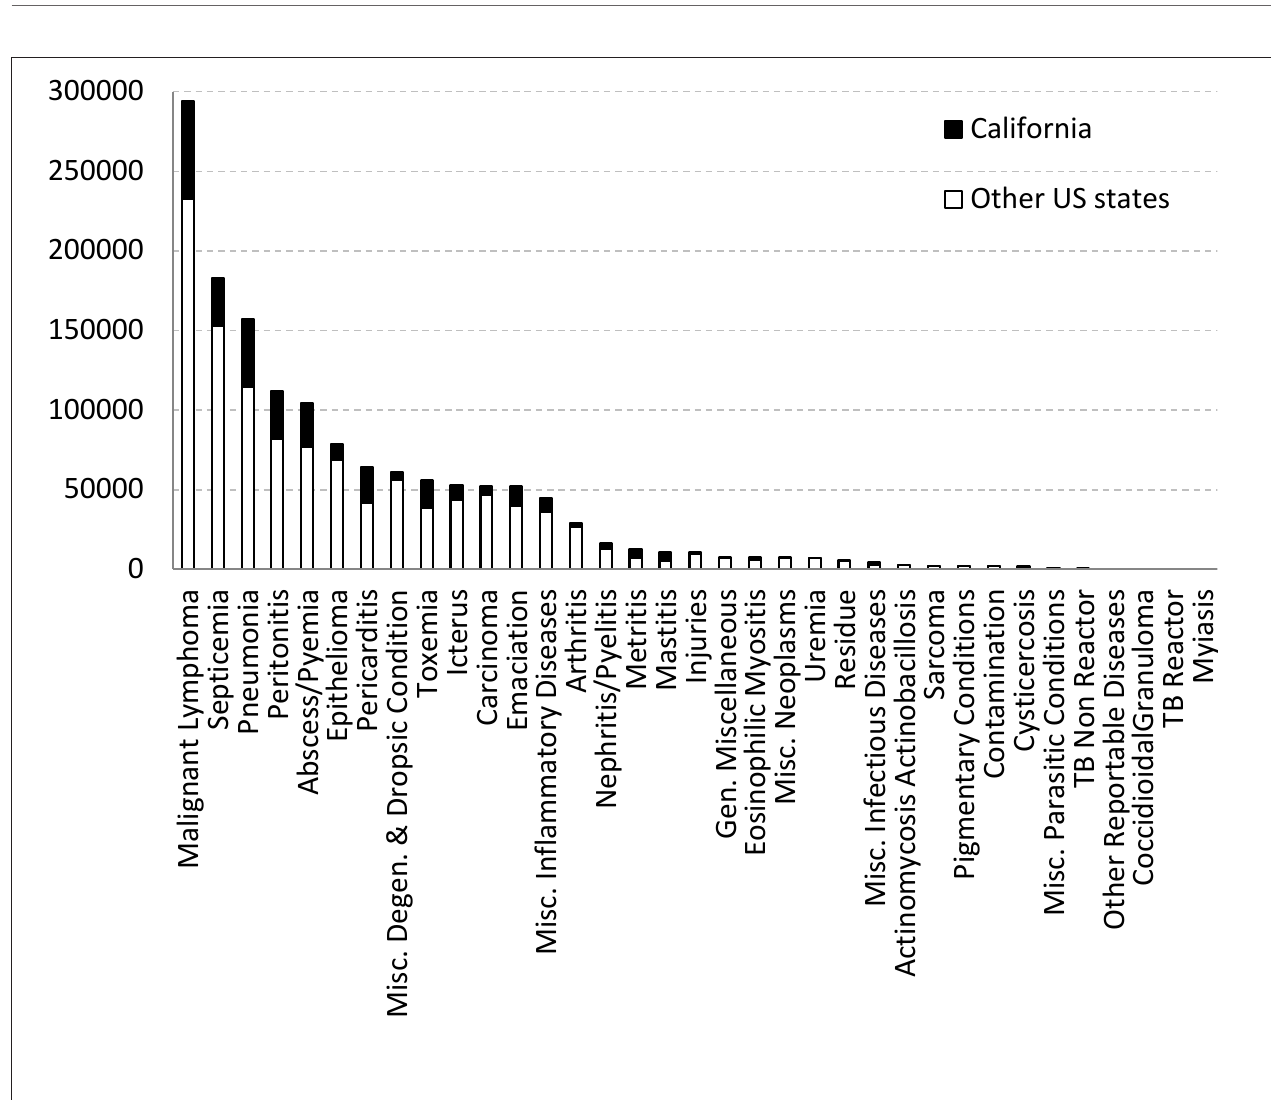
FigUre 1 | Total number of carcass condemnations per reason in slaughterhouses in California (black) and in other US states (white) from Jan-2005 to